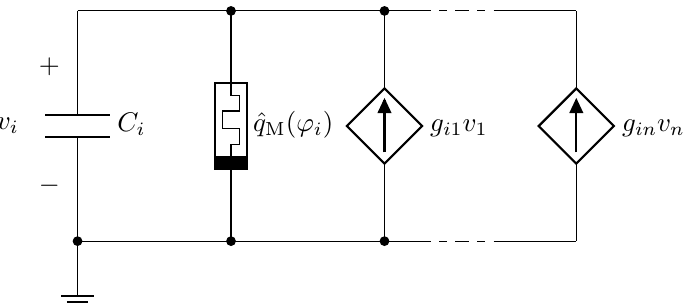
Figure 3. Circuit schematic for the i -th cell of an IMNN. The cell is obtained by replacing the linear resistor in a CNN cell with a flux-controlled ideal memristor. The interconnections are obtained via linear conductances g ij . The VCCSs represent the currents g ij v j , j = 1,2, . . . , n , which are injected into the cell due to the interconnections with the other